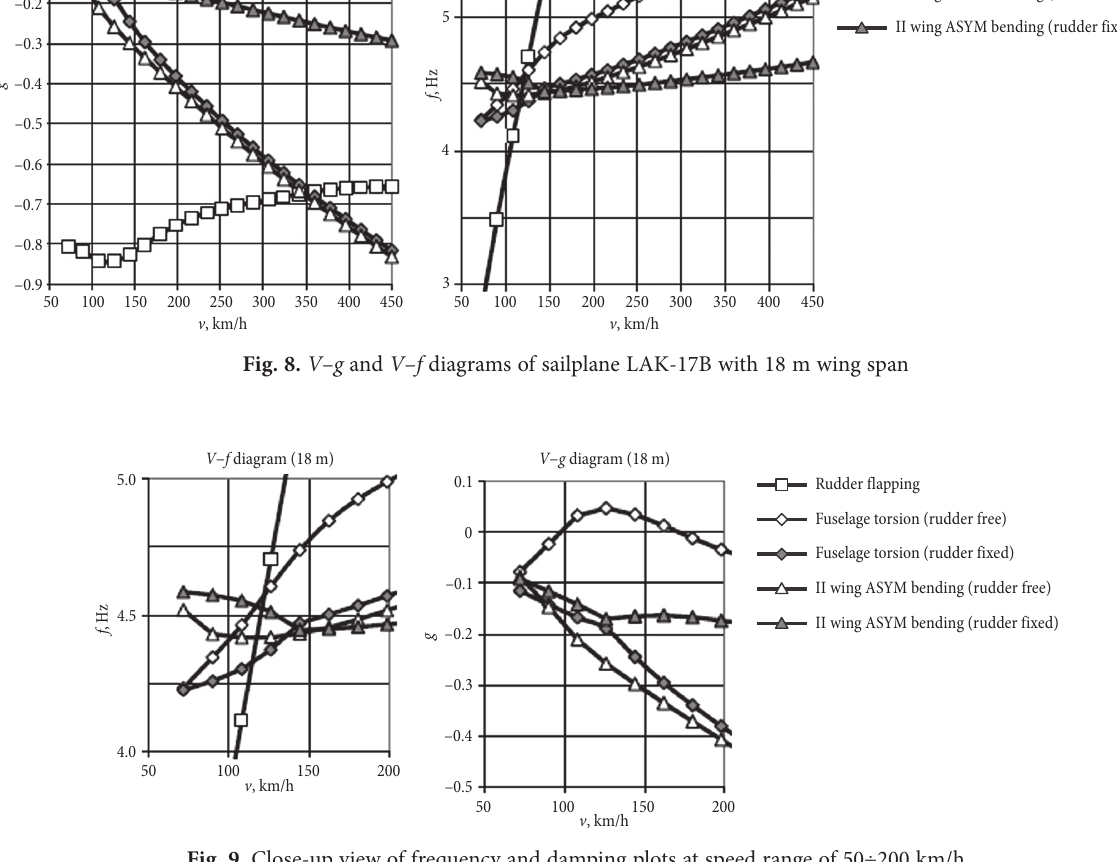
Fig. 9. Close-up view of frequency and damping plots at speed range of 50÷200 km/h